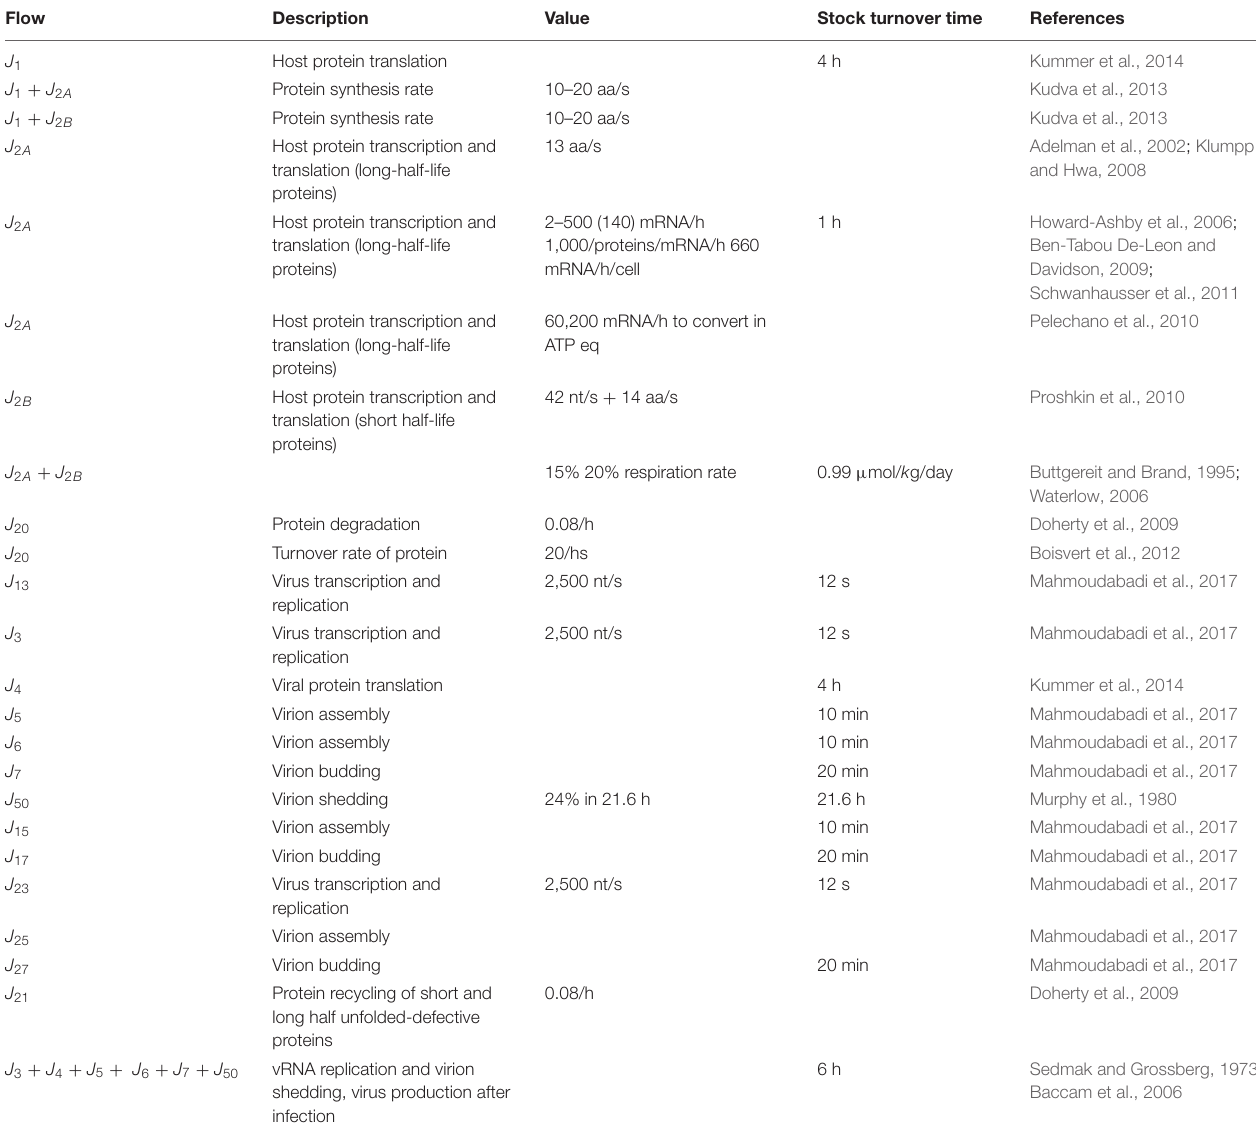
TABLE 2 | Relevant flows included for the diagram and simulator